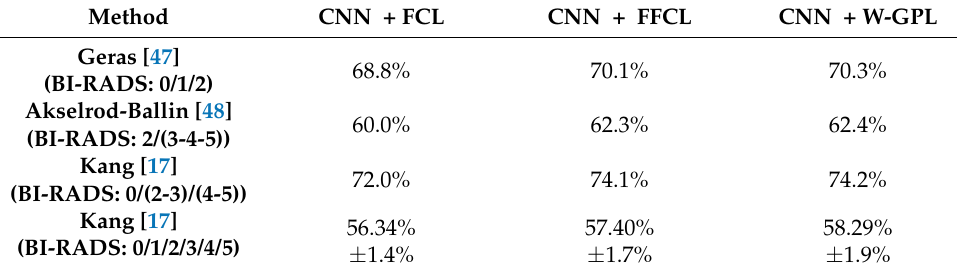
Table 4. Comparison with existing methods on DDSM in terms of ACC.